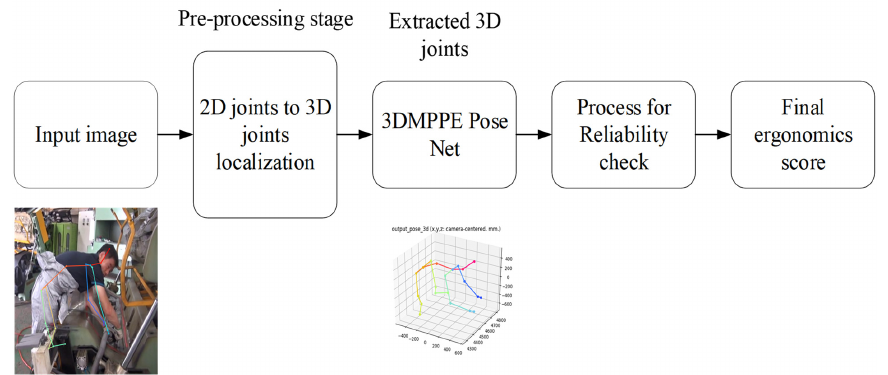
Figure 1. Block diagram of BARD network framework.